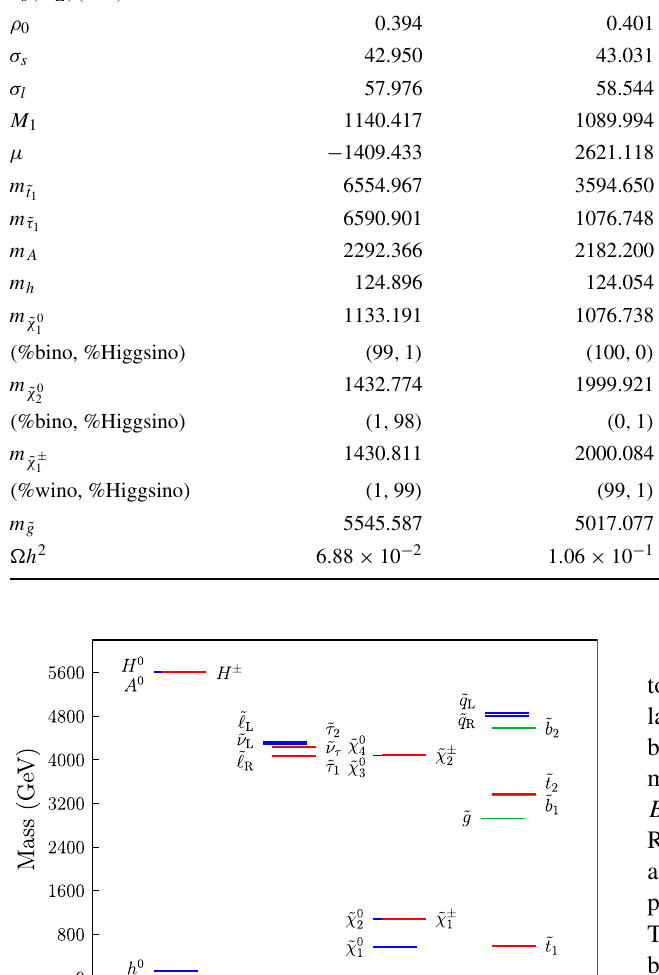
only or SM prediction can be improved on by including a BSM contribution, a more nuanced calculation is